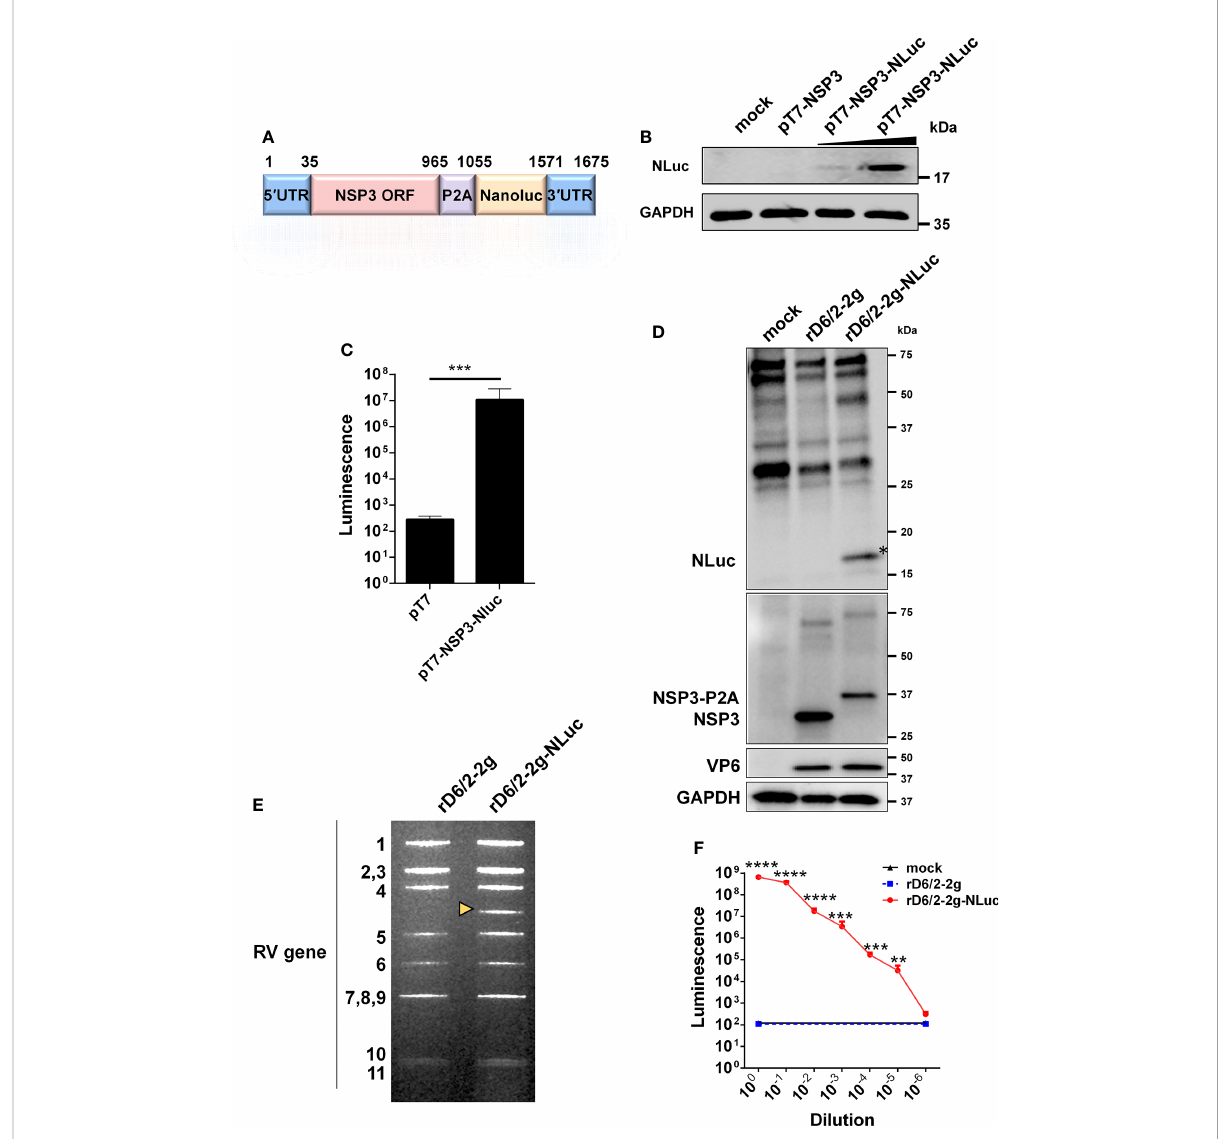
FIGURE 1 Generationandvalidationof abioluminescent rD6/2-2g-NLuc. (A) Aschematicdiagram(not toscale)of agenetically engineeredpT7plasmidthat encodes NLucwithnucleotidepositionsindicated. UTR, untranslatedregion;P2A, self-cleavingP2Apeptide geneofporcineteschovirus-1. (B) BHK-T7 cellsweretransfectedwithpT7-NSP3andincreasingamounts of pT7-NSP3-NLucfor48hours, andcell lysateswereanalyzed by western blot. (C)